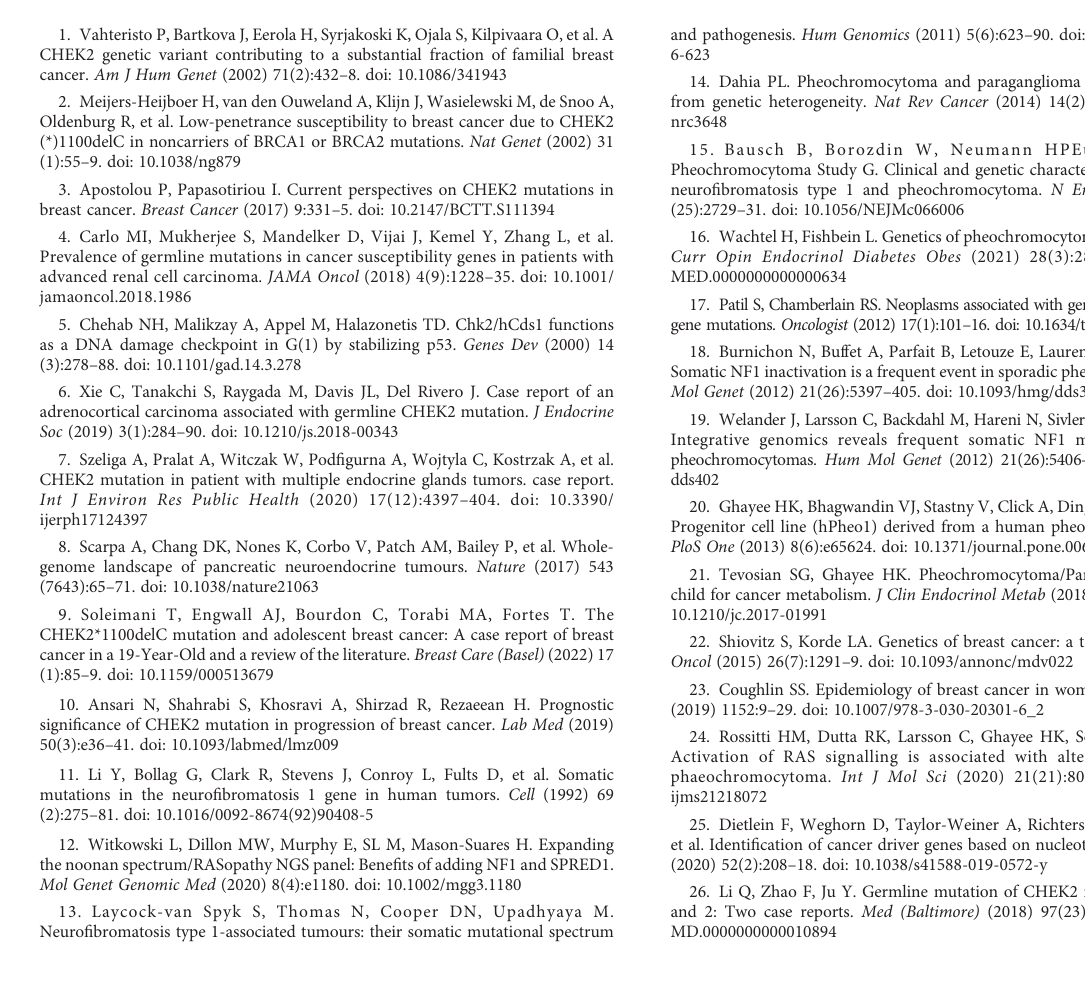
SUPPLEMENTARY FIGURE 1 Sanger sequencing traces on CHEK2 of the proband ’ s pituitary adenoma, obtained from formalin- fi xed paraf fi n embedded (FFPE) tissue, showing the presence of a frameshift variant (c.1000delC, arrow). Representation of the normal, wild-type (WT) allele and the variant allele are shown, indicating an almost 50-50 distribution, consistent with retention of both alleles or the presence of nontumoral admixed cells in the